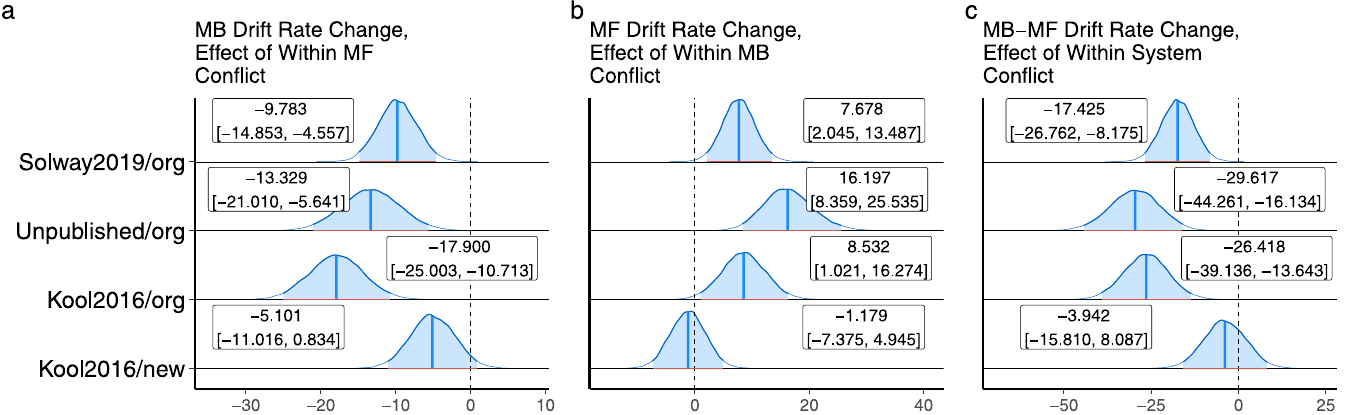
Fig 6. A. The effect of within-system model-free conflict (Q-value differences) on the strength of model-based control. B. The effect of within-system model-based conflict (Q-value differences) on the strength of model-free control. C. Differences between the effects on model-based and model-free control.